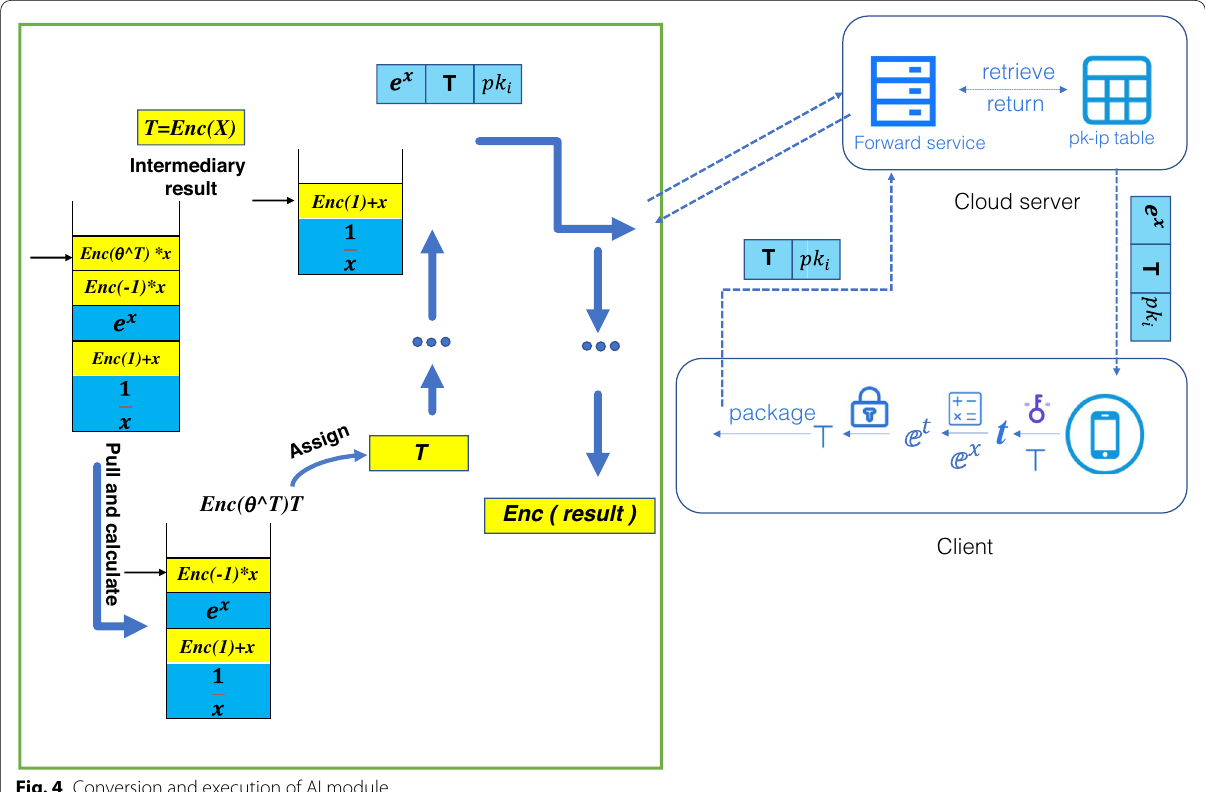
Fig. 4 Conversion and execution of AI